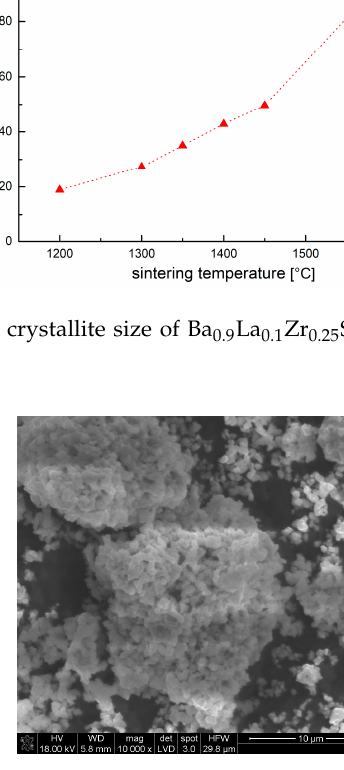
Figure 4. Scanning electron microscopy (SEM) micrograph of Ba 0.9 La 0.1 Zr 0.25 Sn 0.25 In 0.5 O 3 − a material (crushed and grinded pellet) sintered at 1400 °C.